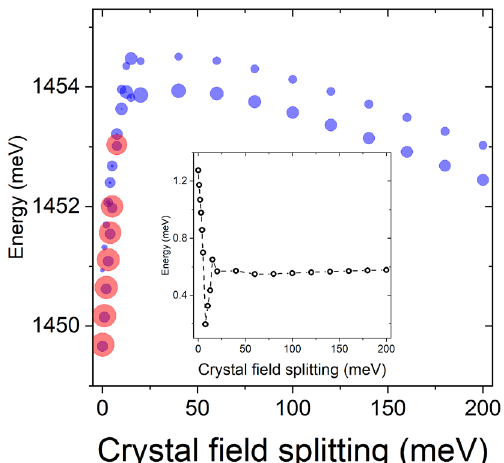
Figure 6. Energy spectra of the lowest two excitonic branches for a crystal phase quantum with H = 1 nm, D = 23.5 nm. The size of each circle corresponds to the state’s optical activity. The red color for small crystal field splitting values corresponds to out-of-plane (z) polarized (along the nanowire) emission, whereas the blue color corresponds to the in-plane (x/y) polarization of emitted light. The inset shows the energy spacing between lower and higher exciton branches